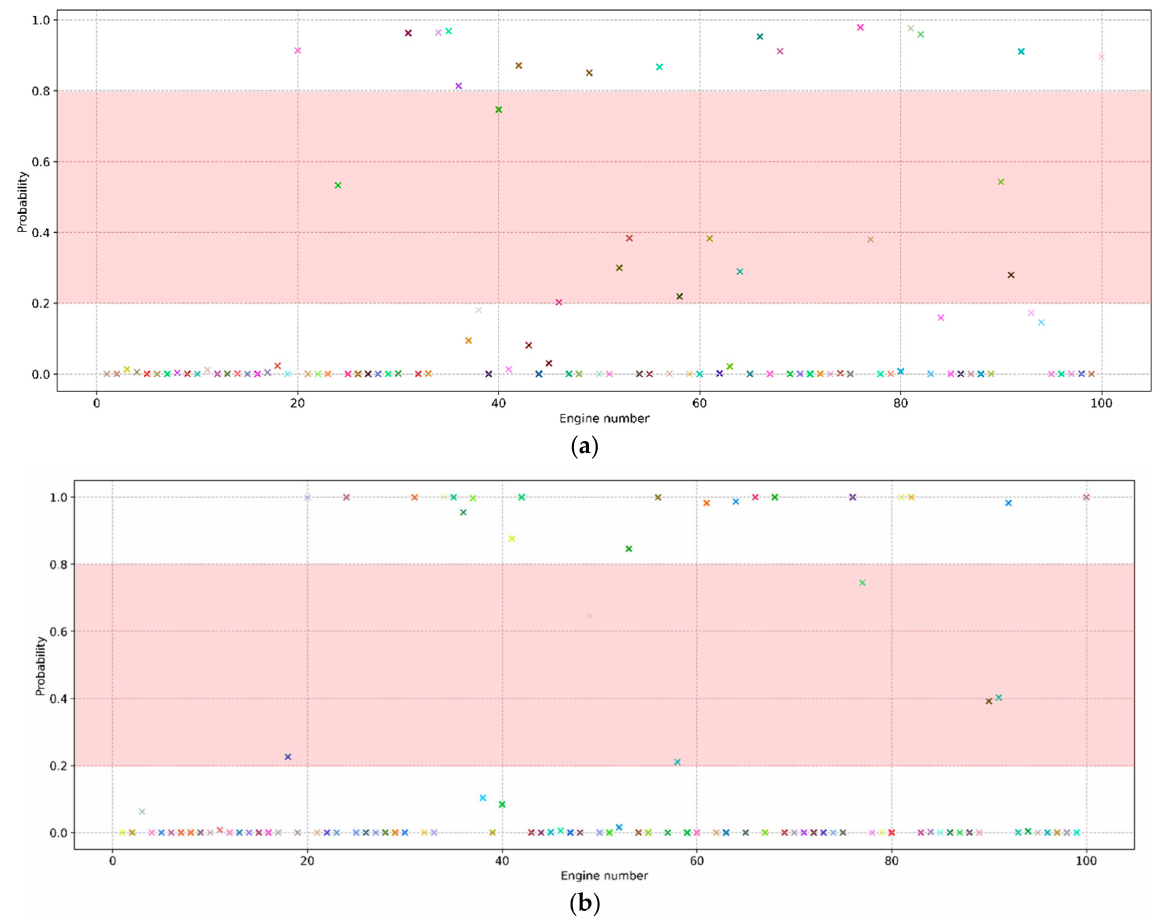
Figure 5. Probabilities of engine failure in the next 30 cycles for the model trained on data without ( a ) and with ( b ) a sliding window. The area highlighted in red contains engines that cannot be assigned to any class with a high degree of